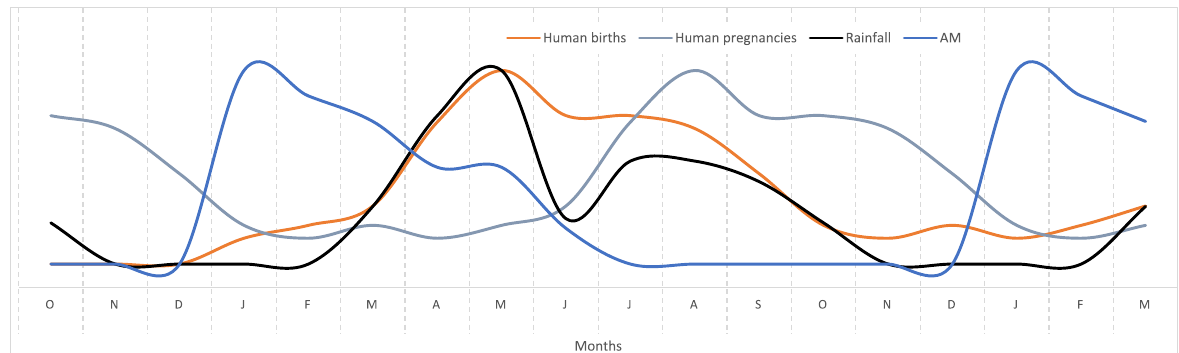
Fig. 4 Monthly patterns of pregnancies, births, rainfall and acute malnutrition in children. Note : The graph is derived from monthly calendars with 16 independent women’s groups and median scores; the monthly calendar method used a 12-month period; the graph shows an 18-month period to clarify trends between December and January. The monthly calendar did not include an indicator for pregnancy and so the pregnancy pattern was derived from the birth indicator. AM, acute child